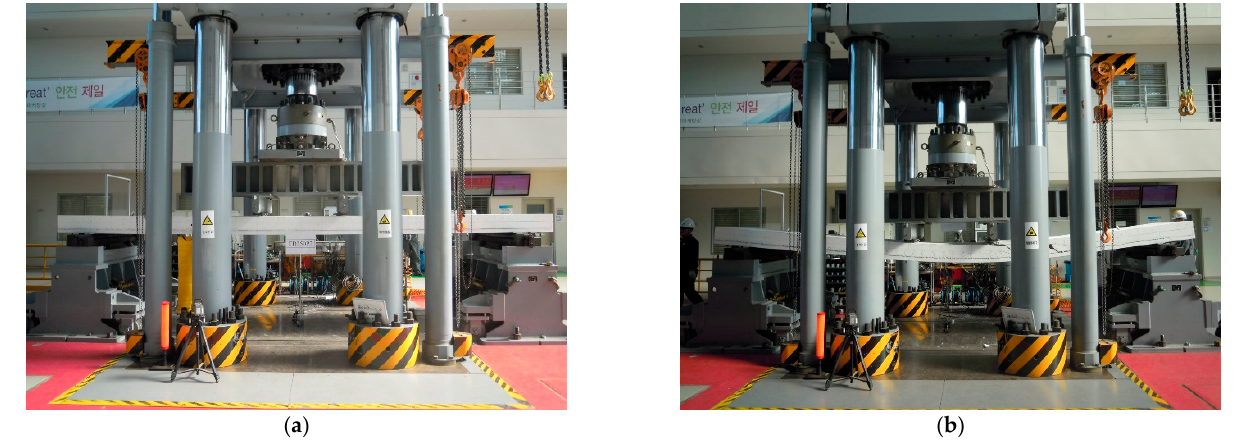
Figure 5. Photos of experimental tests: ( a ) before the loading test; ( b ) after